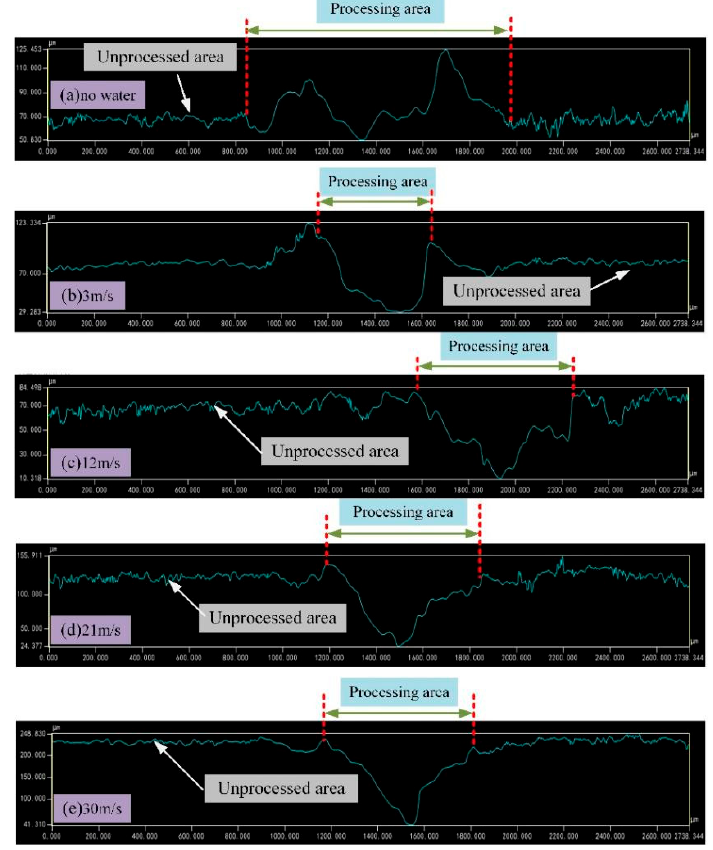
Figure 2. Groove profile.